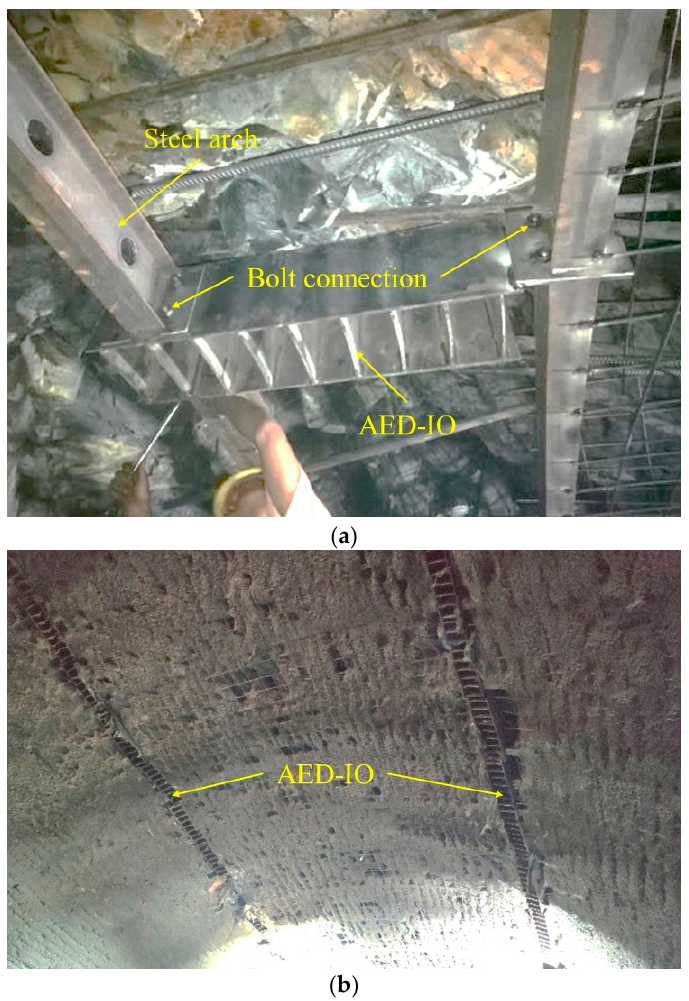
Figure 17. Actual installation: ( a ) connecting the steel arches; ( b ) filled with concrete.